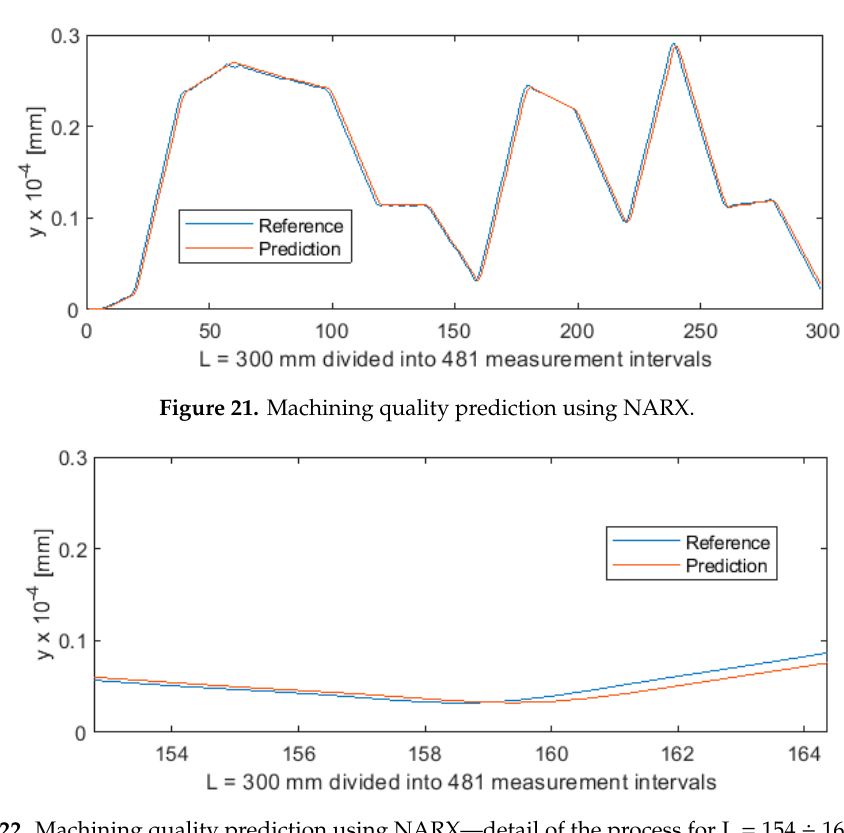
Figure 22. Machining quality prediction using NARX—detail of the process for L = 154 ÷ 165 mm in Figure 21.